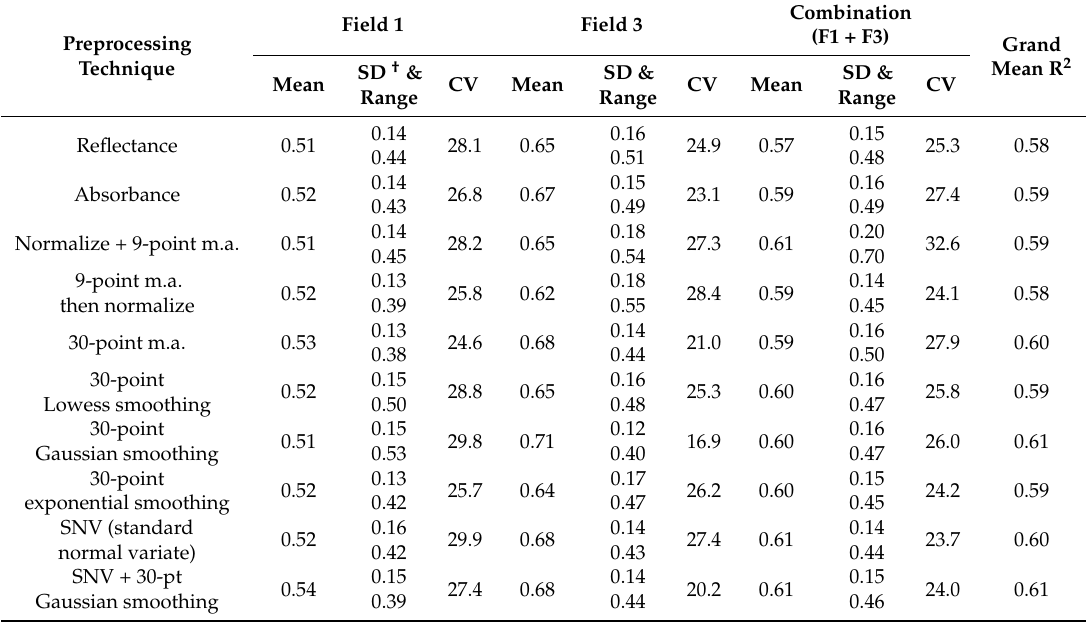
Table 2. Prediction R 2 summary statistics for models using different spectral preprocessing techniques and calculated with partial least squares regression (PLSR) applied to the combined dataset including depth, EC a , CI, and spectra (DECS) for the individual fields and the combined field dataset. For each preprocessing technique and dataset, R 2 statistics were across models for all soil properties. Grand mean R 2 is the mean of the three datasets. Coefficient of variation (CV) is in %.